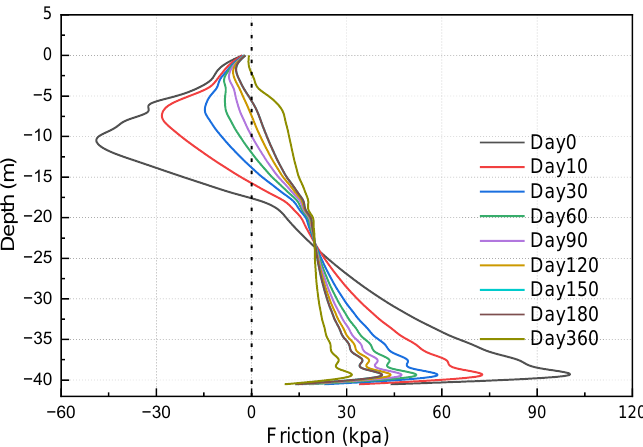
Figure 8. Friction distribution of the piles in two years after filling (times in the legend represent